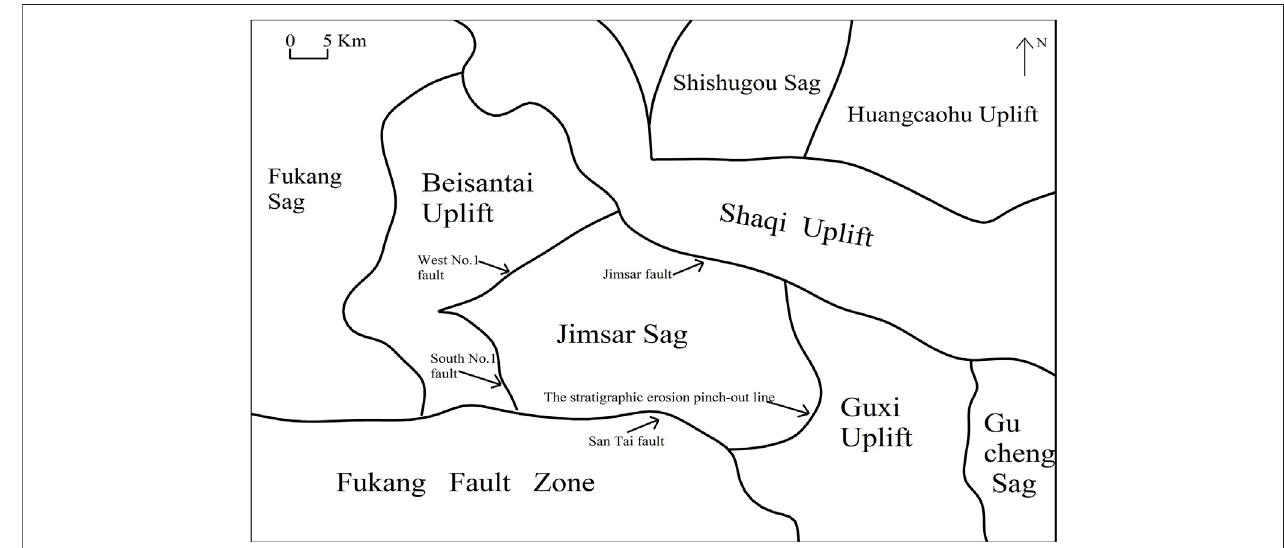
FIGURE 1 | Location map of the study area.